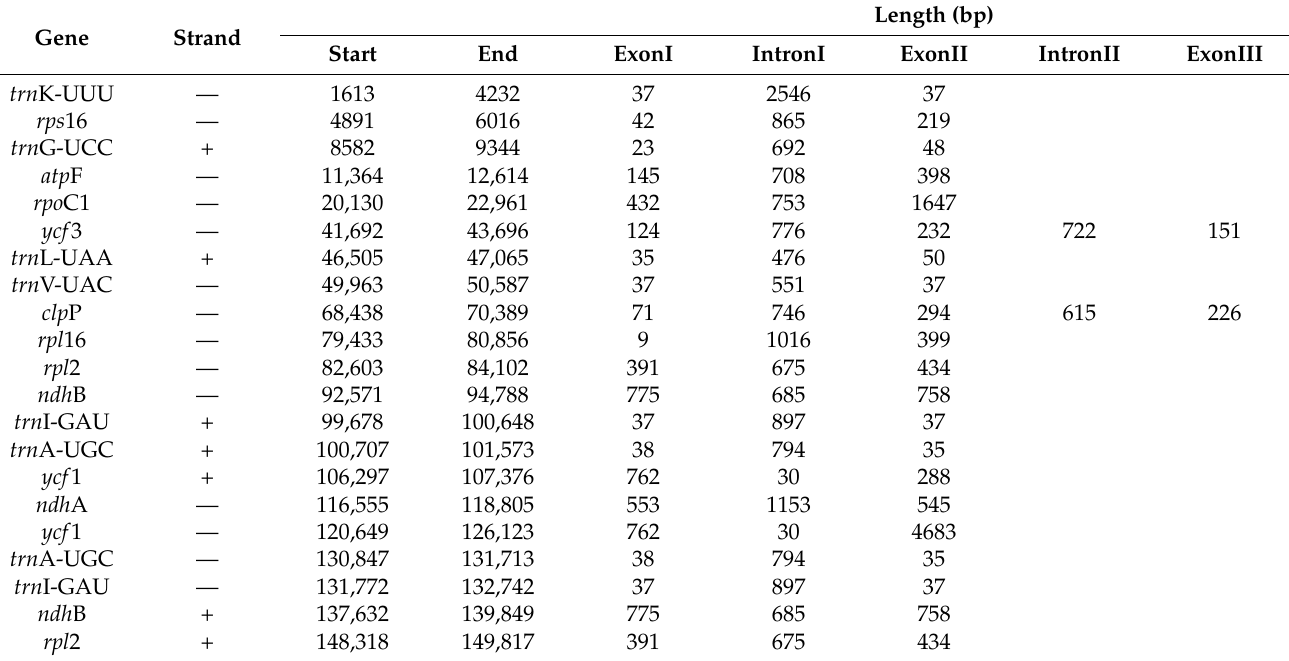
Table 3. The lengths of introns and exons for the splitting genes.